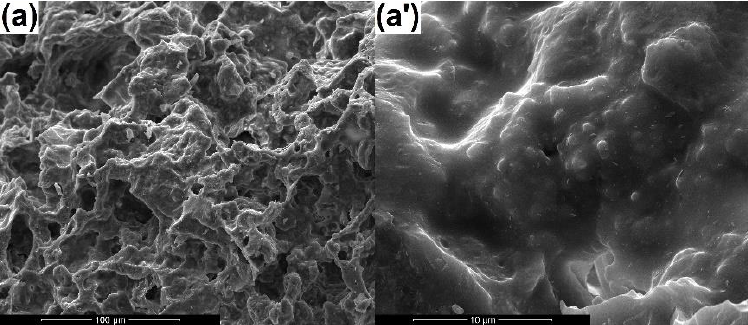
Figure 1. SEM images of the target: ( a ) 1,000× and ( a’ ) 10,000×.